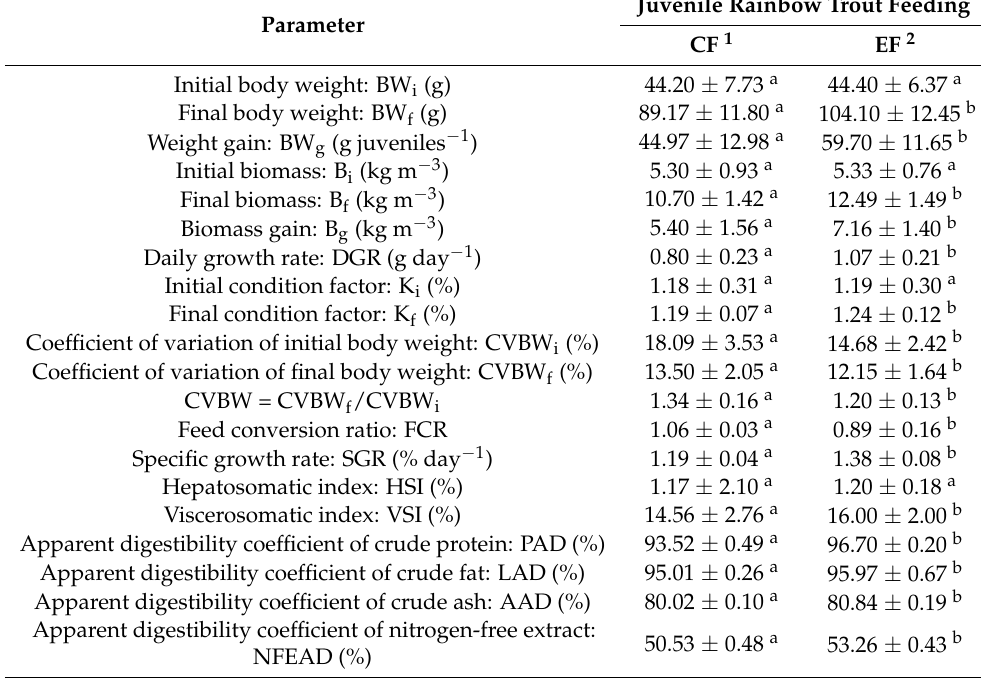
Table 2. Rearing parameters and apparent nutrient digestibility in juvenile rainbow trout fed with a commercial feed (Aller Gold) and feed supplemented with 0.1% of the Carnobacterium maltaromaticum environmental probiotic strain (mean value ± SD; n = 3). The dietary treatments are described in the Materials and Methods section. Groups marked with different letters in the same row differ significantly (Mann–Whitney U test p < 0.05; n =